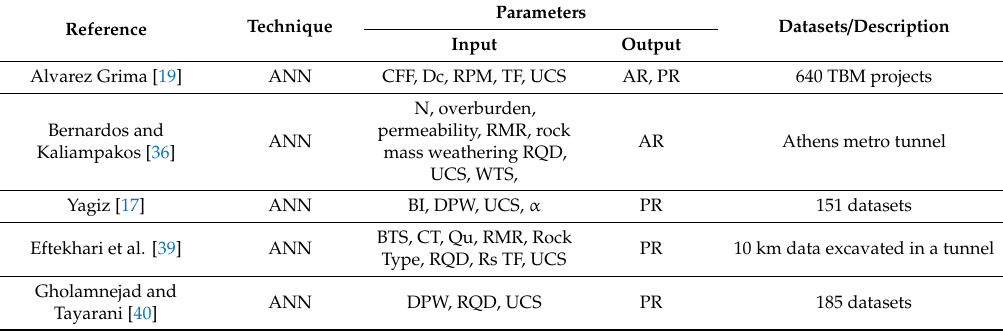
Table 1. Published research on tunnel boring machine (TBM) performance prediction using related artificial intelligence (AI) and machine learning (ML)